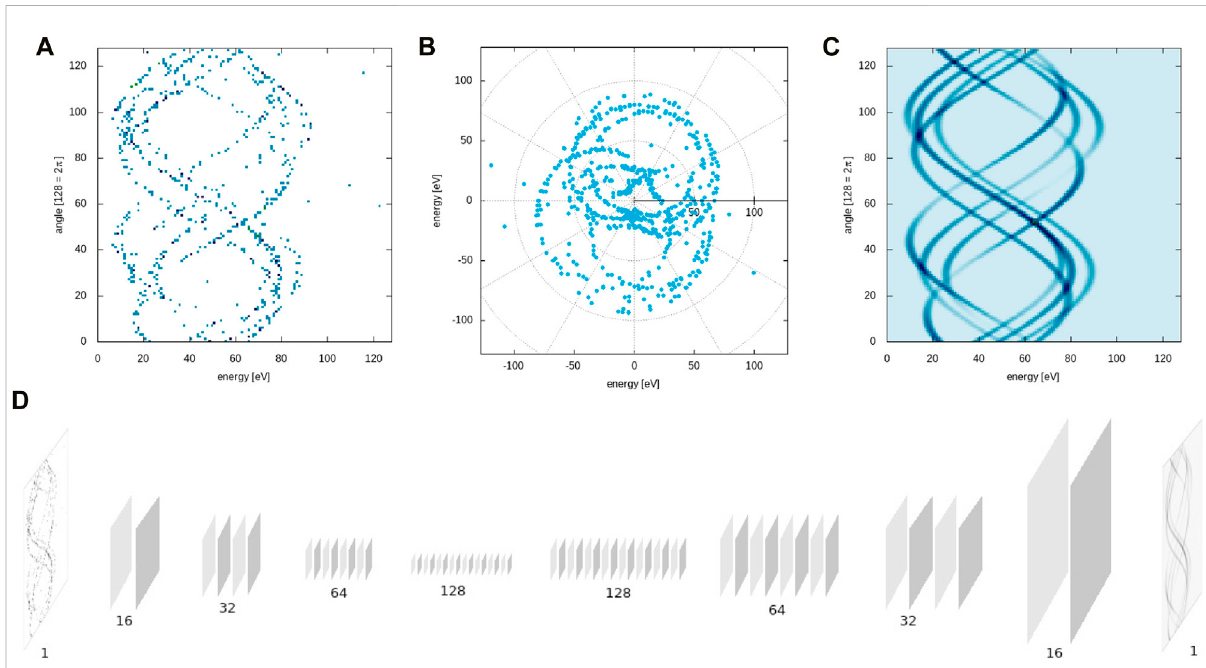
FIGURE 1 (A) . Cartesian “ image ” representation of the in energy-angle space (our input X ). (B) . Polar representation of an example streaking shot. (C) . Cartesian “ image ” representation of the energy-angle emission probability distribution (our output Y ). (D) . Schematic of the CookieNetAE as described in Table